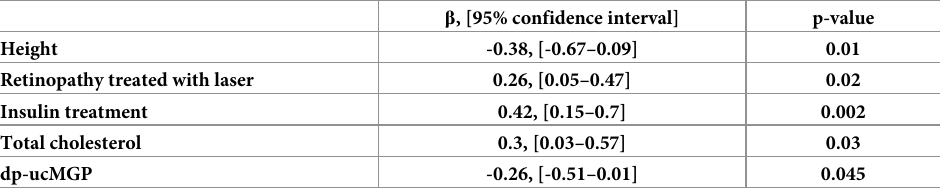
Table 3. Multivariate analysis: Correlations between clinical and biological variables and diabetic neuropathy (NDS � 6). β , [95% confidence interval] p-value Height -0.38, [-0.67–0.09] 0.01 Retinopathy treated with laser 0.26, [0.05–0.47] 0.02 Insulin treatment 0.42, [0.15–0.7] 0.002 Total cholesterol 0.3, [0.03–0.57] 0.03 dp-ucMGP -0.26, [-0.51–0.01] 0.045 Multivariate analysis was performed using ANCOVA. 95% confidence interval of the standardized coefficient is presented in brackets. Correlations are significant if p < 0.05. Significant results are presented in